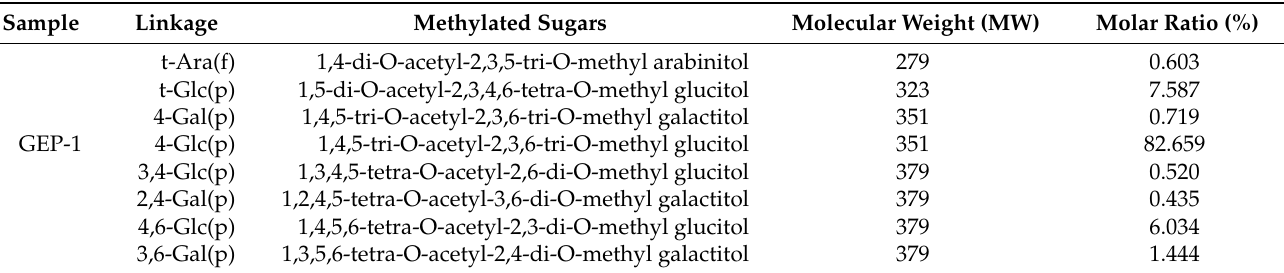
Table 2. Methylation analysis of GEP-1.